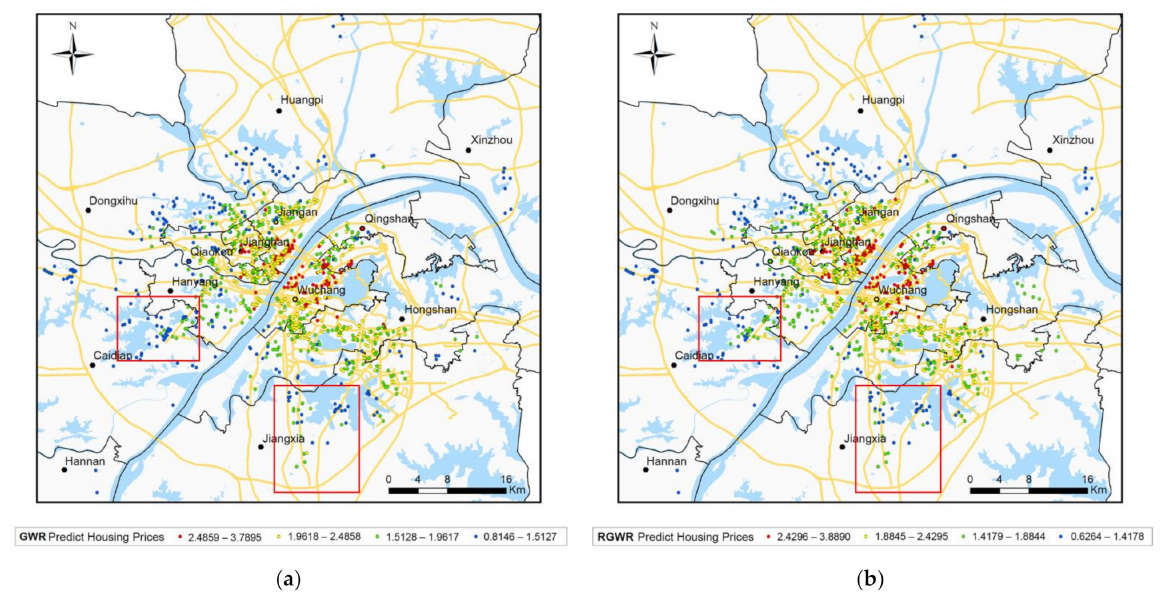
Figure 10. The predicted housing prices of different models. ( a ) The predicted housing prices of the GWR model; ( b ) The predicted housing prices of the RGWR